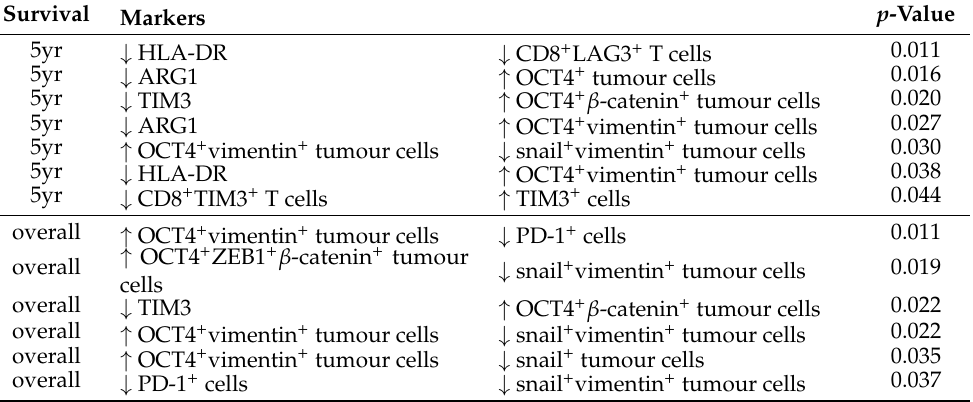
Table 1. Table of pairs of markers that were insignificant in univariate Cox regression individually ( p > 0.05) but when used together as input to a multivariate Cox model achieved p < 0.05 after Chow–Denning correction. Markers annotated with ↑ exhibit positive correlation with the event, whereas ↓ denotes negative